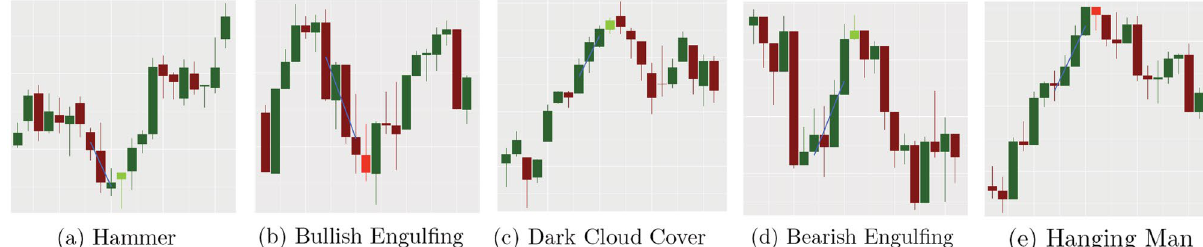
Figure 4. Examples of accurate forecasting via candlestick patterns. The x -axis provides an index of time with each candle representing one time period, while the y -axis indicates the value of some positive-valued measurable quantity (traditionally, share price). Axes values have been omitted as they are unimportant for these illustrations. The blue line indicates the 4-day trend lines established via linear regression, confirming either an appropriate uptrend or downtrend. The light colored candle indicates the start of each candlestick pattern, observe that in all cases shown the pattern corresponds to a trend reversal.